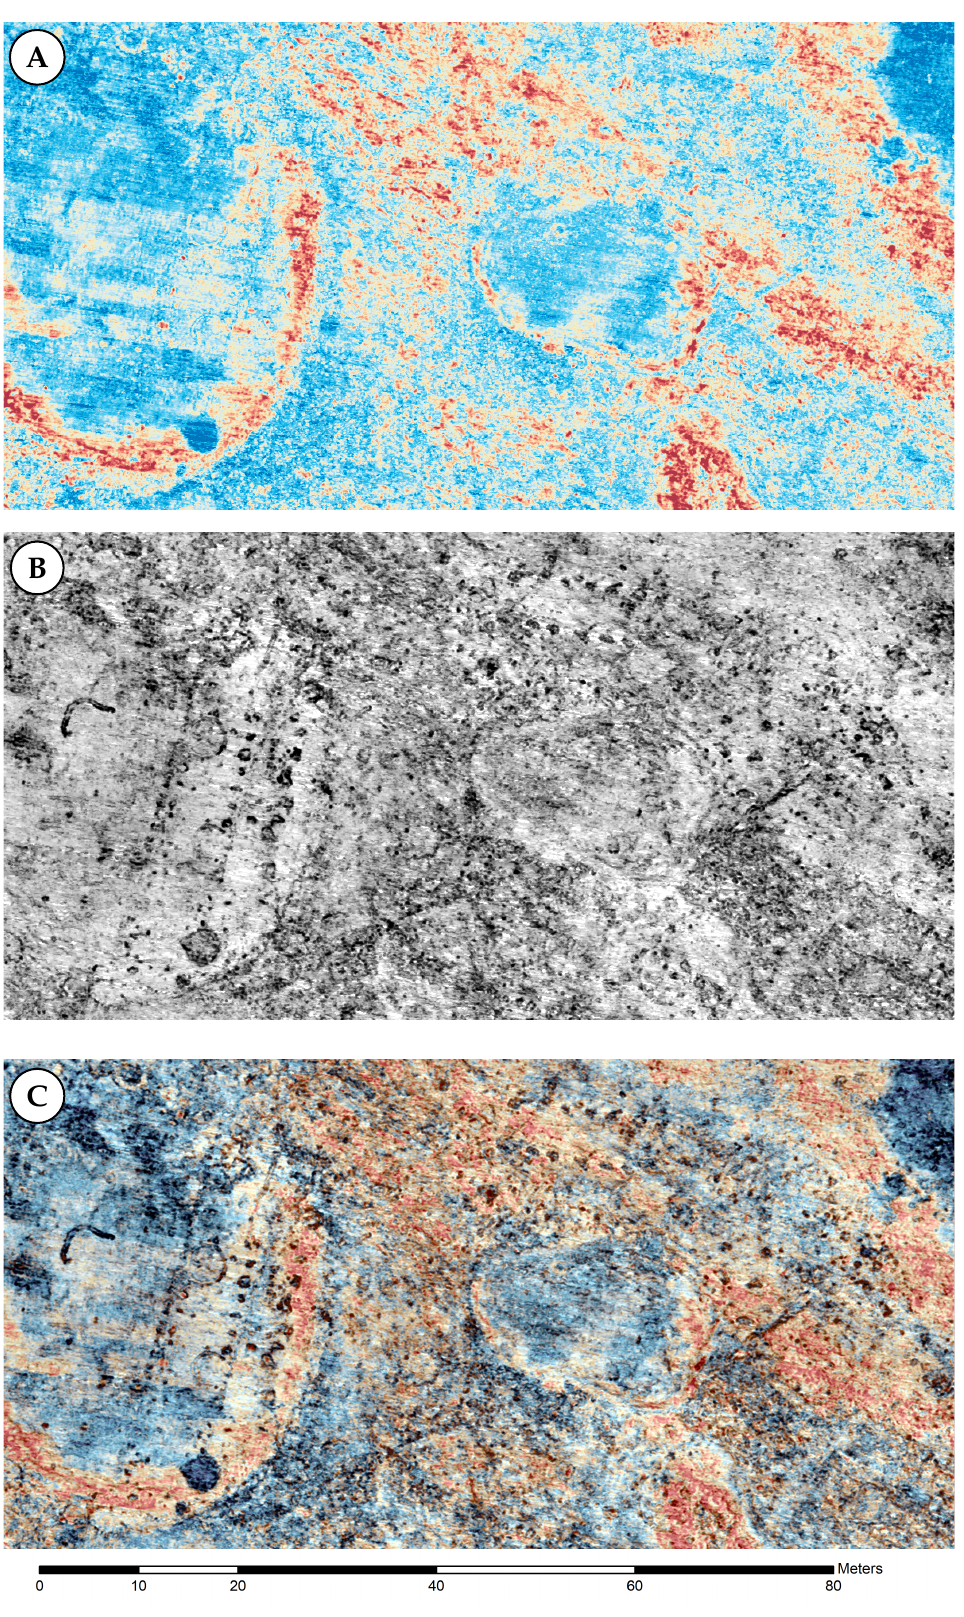
Figure 4. ( A ) Conventional GPR amplitude map after Hilbert transformation of the data showing a 5 cm thick depth-slice from approximately 40–45 cm depth using a red-white-blue seismic colour scale. ( B ) Coherence map for the same depth-range as grey-scale image. ( C ) Fusion of the two images